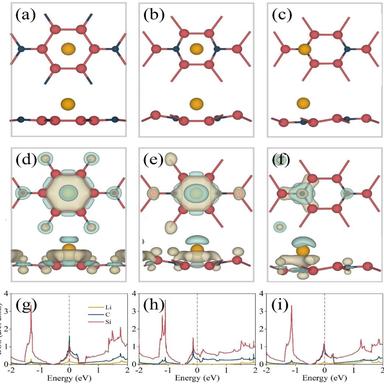
Configurations of Li adsorbed on (a) A1, (b) A2 and (c) A3 sites. The charge-density difference of Li adsorbed on (d) A1, (e) A2 and (f) A3 sites. Dark gray, brick red and orange spheres represent C, Si, and Li atoms, respectively. Canary and cyan regions represent electron accumulation and depletion, respectively. The value of the isosurface is set to 0.002 electron/Å3 . DOS of Si3C with Li adsorbed on (g) A1, (h) A2 and (i) A3 site. Vertical dashed lines represent the Fermi level.